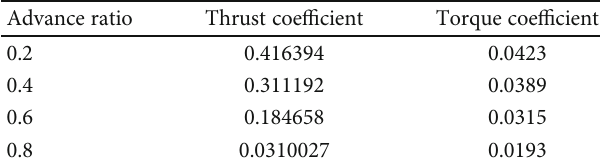
Table 2: Experimental results for validation [3].